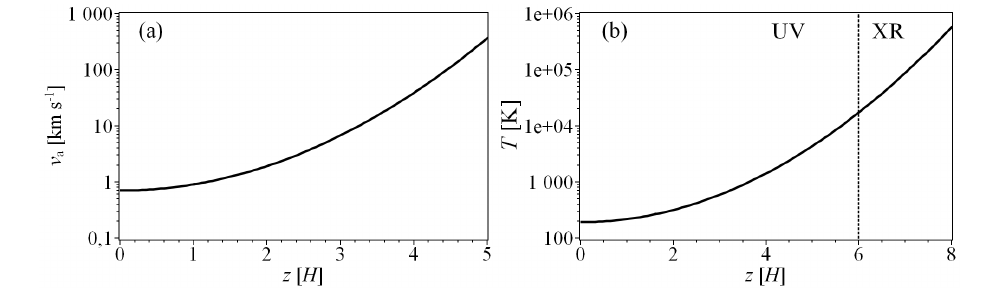
Figure 3. Panel a: dependence of the Alfvén speed on the height of the current layer. Panel b: depen- dence of the temperature of the current layer on its